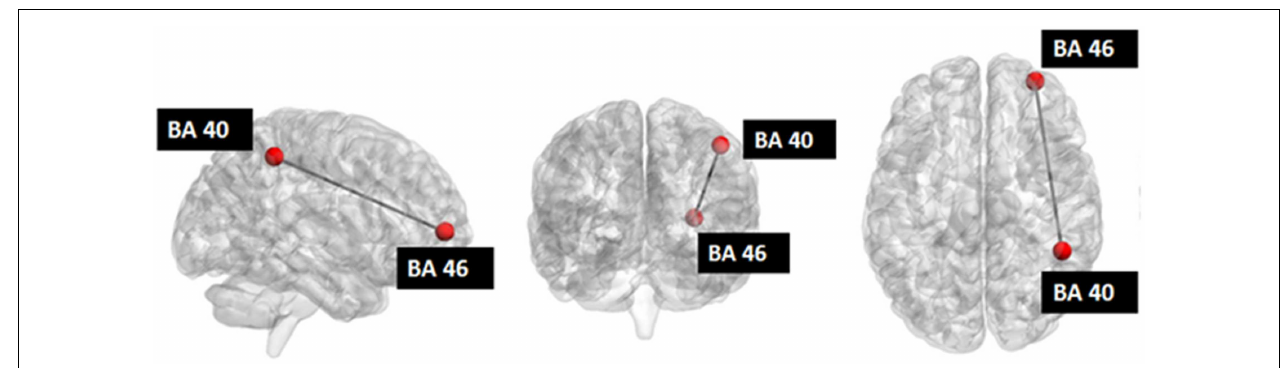
FIGURE 5 | Investigated network: the red nodes indicate the ROIs whose connectivity was decreased after stimulation .